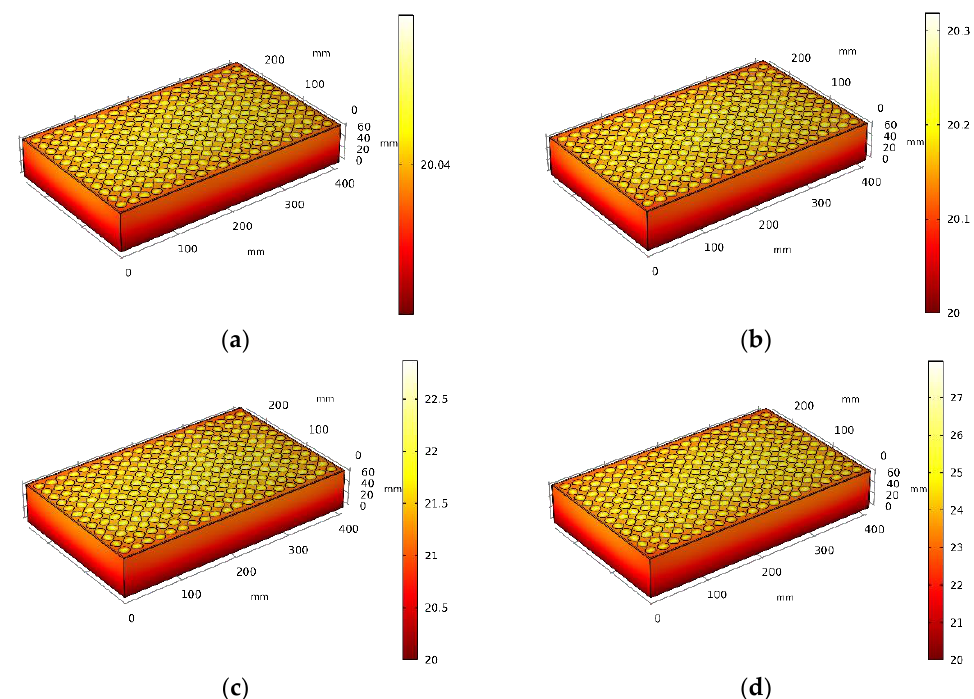
Figure 8. Temperature contours of the entire battery pack in Cu housing while coolant temperature is 20 °C with different C rates ( a ) 0.5C ( b ) 1C ( c ) 3C ( d ) 5C operating at 45 °C ambient temperature.